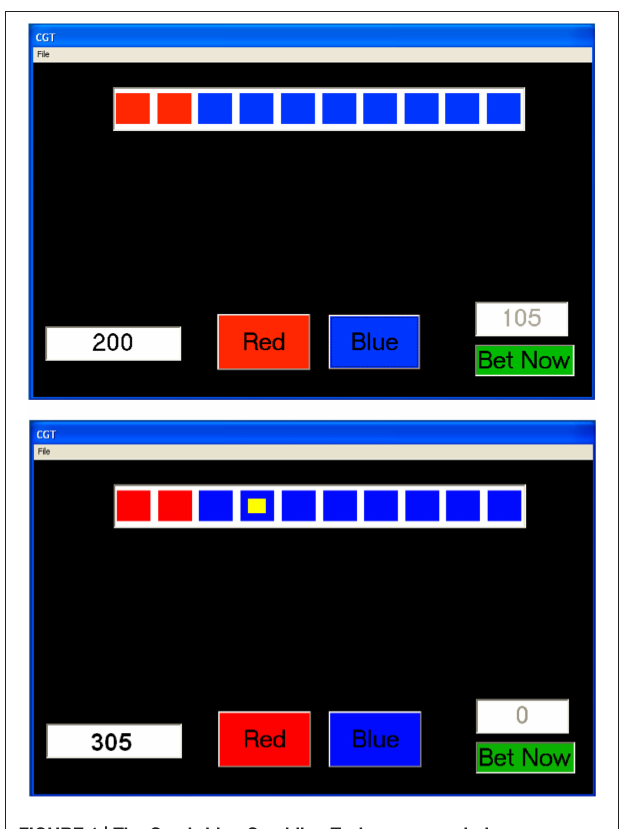
FIGURE 1 | The Cambridge Gambling Task program windows immediately before a bet is made (top, BLUE selected) and immediately after a bet is made (bottom).